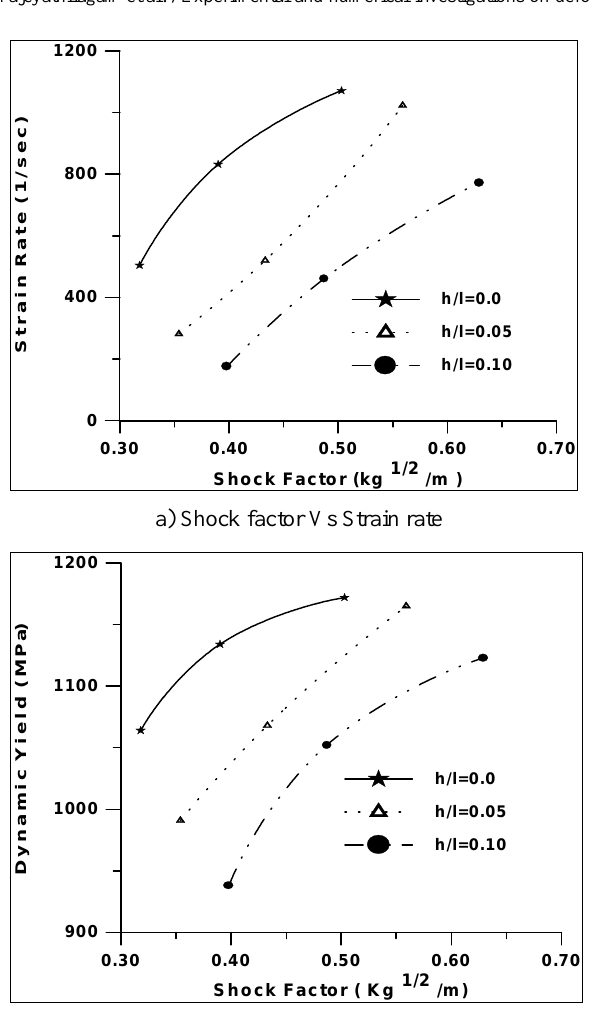
Fig. 12. Strain rate and dynamic yield